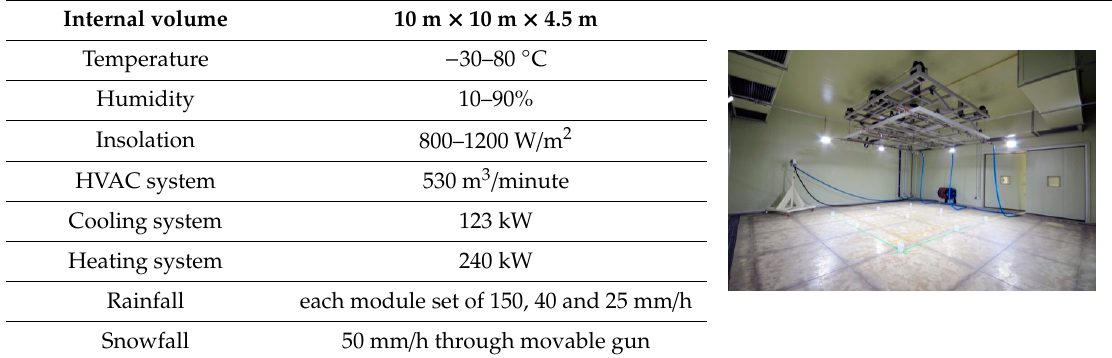
Figure 17. View of RCEC and installation of inner chamber for experiment.